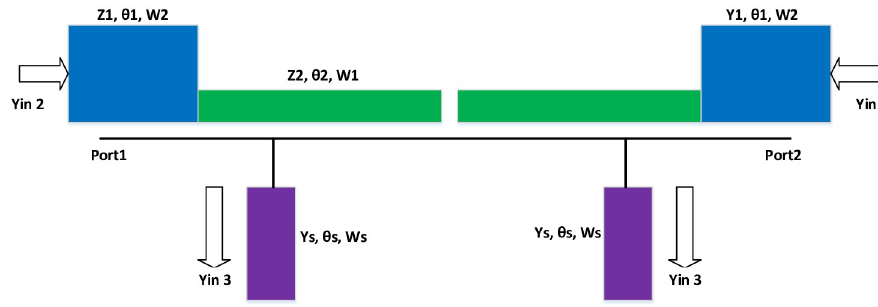
Fig 1. Proposed asymmetric SIR